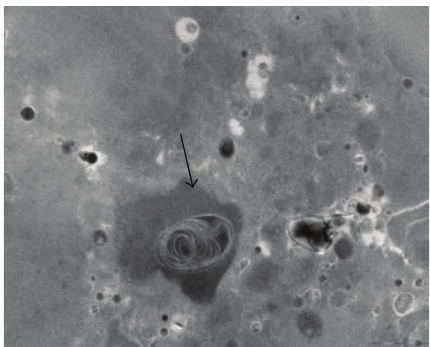
Figure 4: Myelin figure in AKU aortic valve section. TEM obser- vation of a myelin figure perfectly superimposing an extended ochronotic pigmented patch (arrow). Bar 1 𝜇